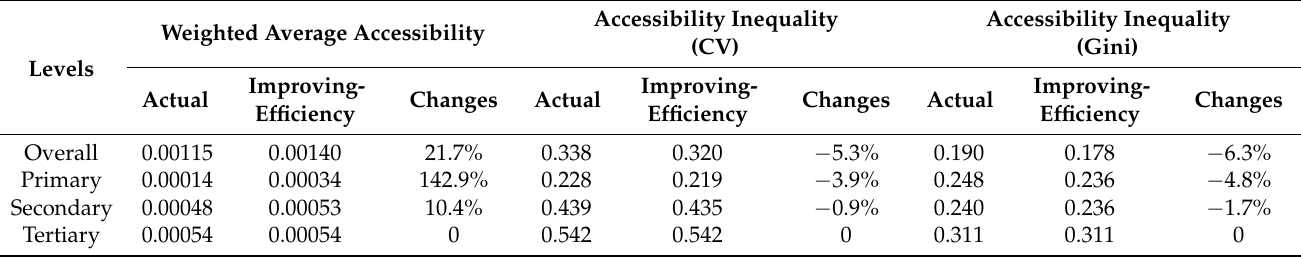
Table 2. Improving-efficiency accessibility impacts of hierarchical healthcare system in Shenzhen. Levels